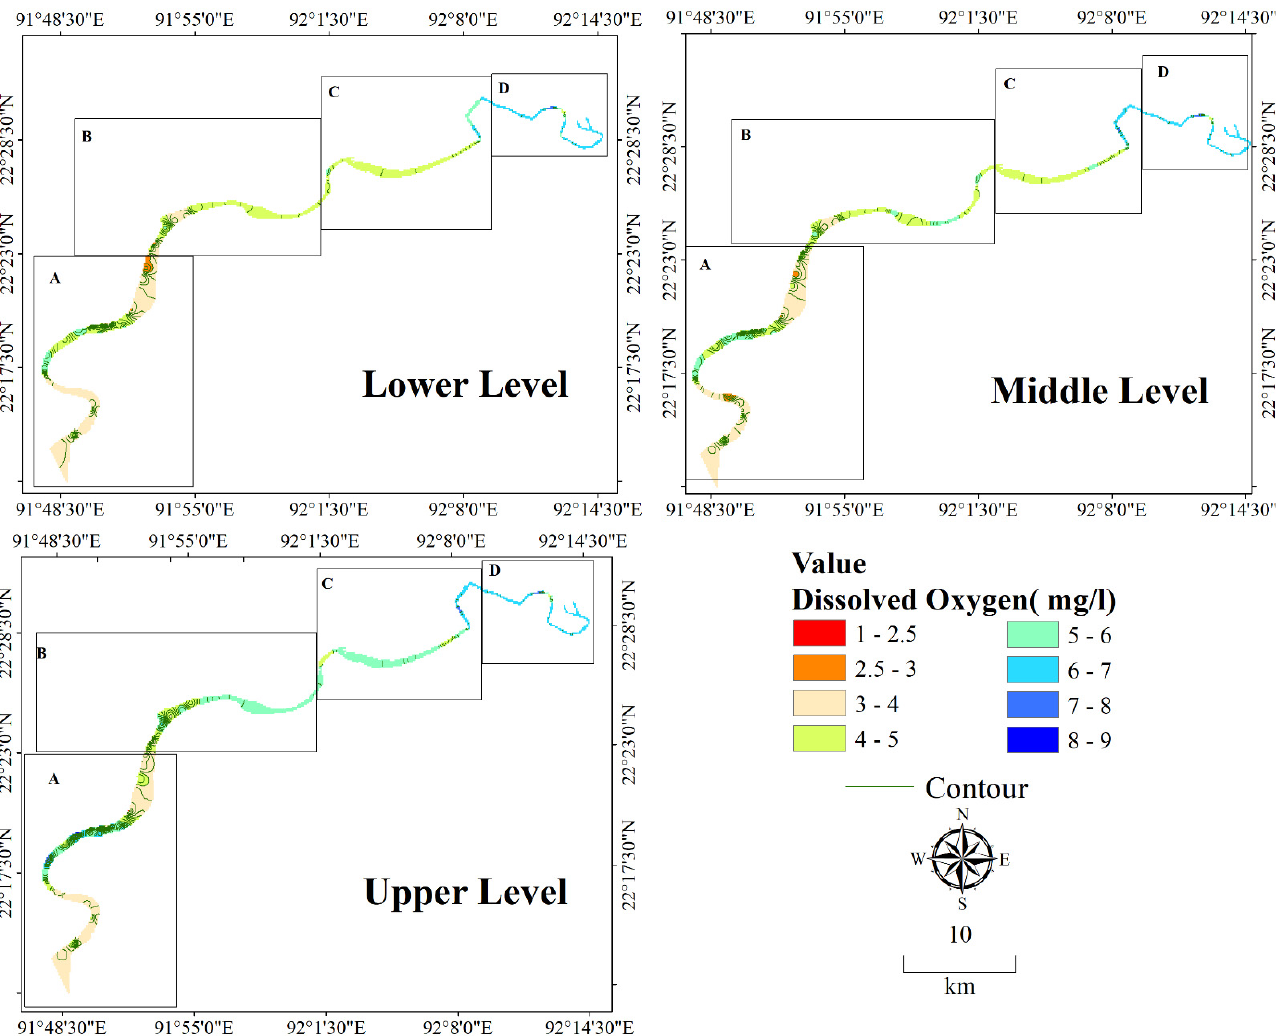
Figure 8. Dissolved oxygen level at different water depths (Dry season) for better visualization subfigures A-D has been added.